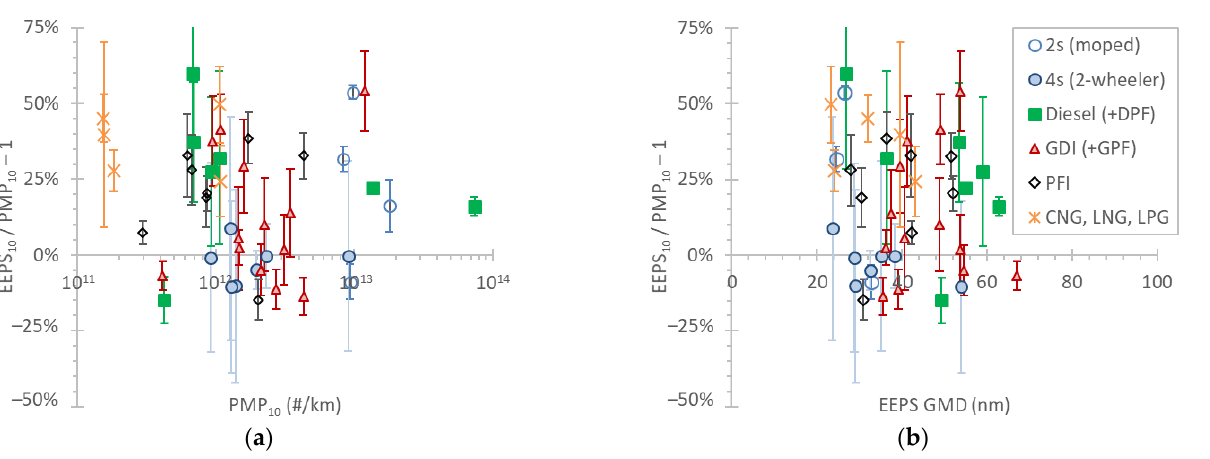
Figure 9. Overview of internal JRC data (details in the text). EEPS to reference PMP systems, both measuring solid particles from around 10 nm. The EEPS was used downstream of a catalytic stripper. In function of: ( a ) concentration levels measured with the PMP system; ( b ) geometric mean diameter (GMD). Both “Default” and “Soot” EEPS matrices are included. Each point is one vehicle. Error bars give one standard deviation of many measurements with the specific vehicle. 2s = two-stroke; 4s = four-stroke; CNG = compressed natural gas; DPF = Diesel particulate filter; EEPS = engine exhaust particle sizer; GDI = gasoline direct injection; GMD = geometric mean diameter; GPF = gasoline particulate filter; LNG = liquefied natural gas; LPG = liquefied petroleum gas; PFI = port fuel injection; PMP = particle measurement